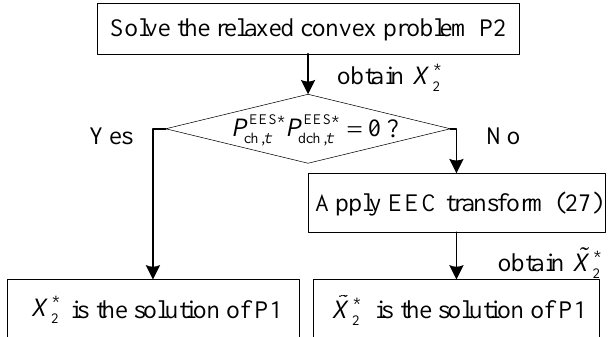
Figure 2. Applying the equivalent-energy-change (EEC)